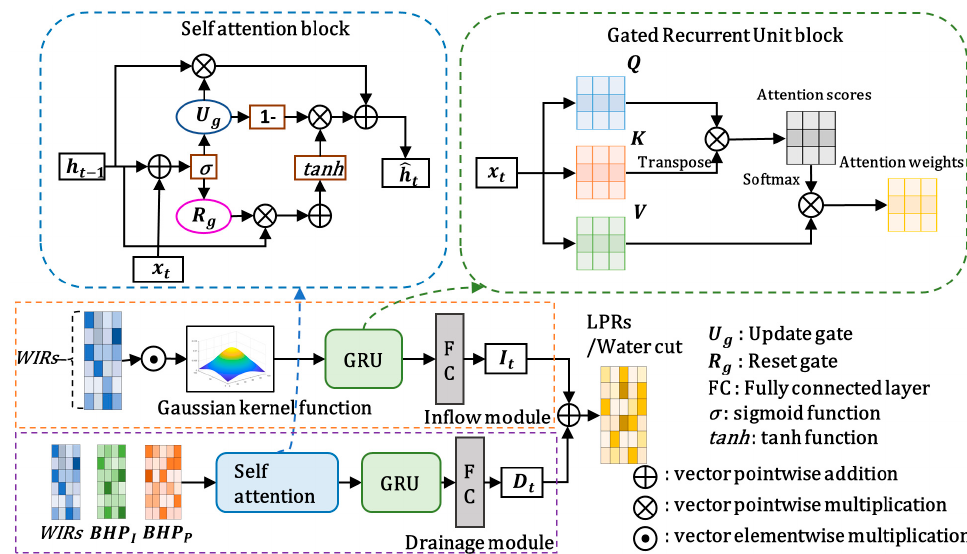
Figure 1. The architecture of the interpretable recurrent neural network.